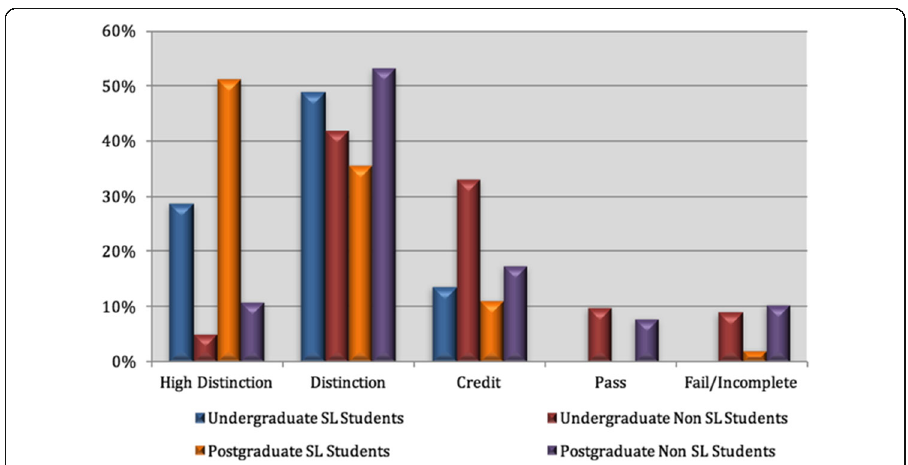
Fig. 11 Comparison of undergraduate and postgraduate results in 2010 across seven education units: those who chose to use Second Life as part of their studies vs those who did